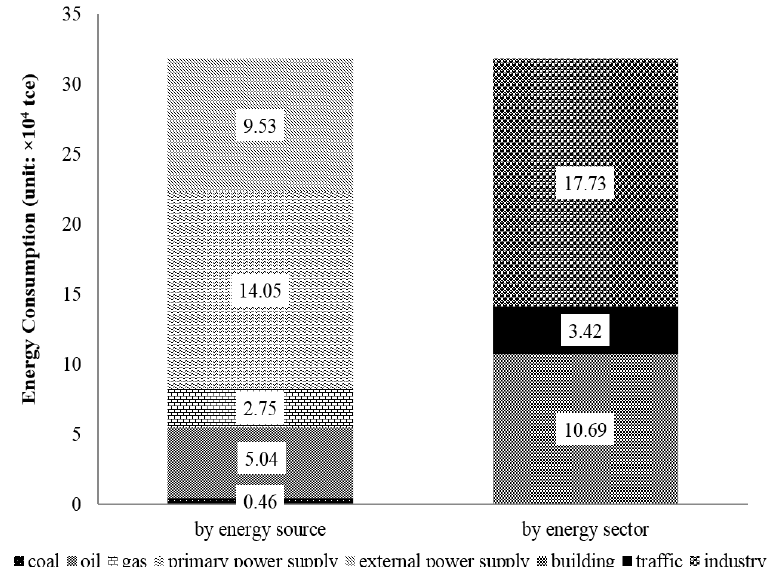
Figure 8. The composition of primary energy consumption.